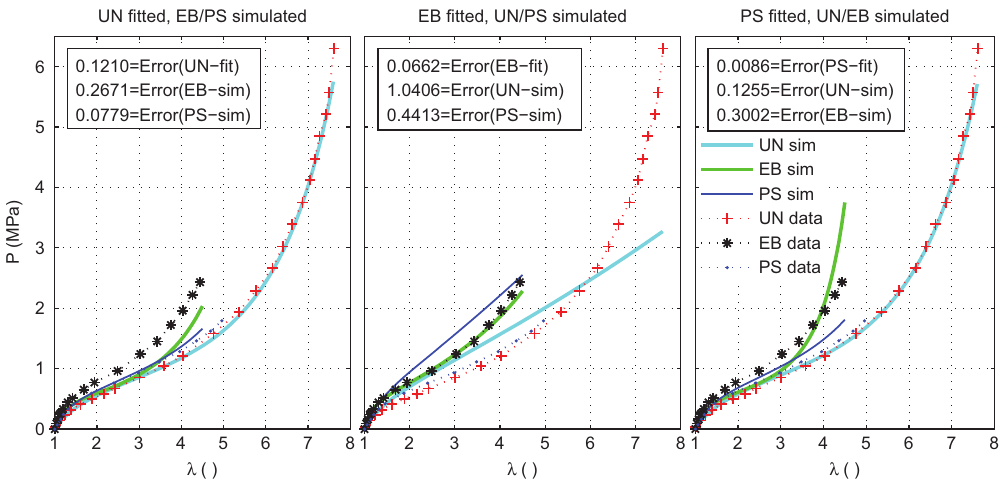
Figure 7 Performance of the van der Waals model on the Treloar